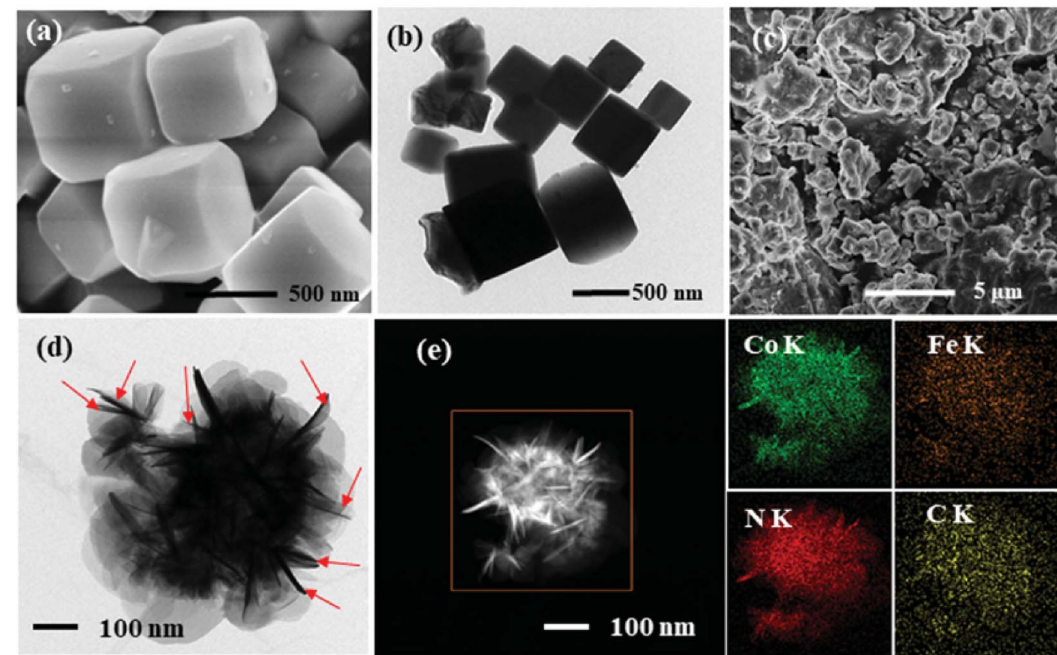
Fig. 7 Morphological and elemental characterization of LDHs. a SEM of PBA, b TEM of PBA, c SEM of PBA/CoFe-LDH, d TEM of PBA/CoFe- LDH and e EDS of PBA/CoFe-LDH, adapted with permission from ref. 145 , Copyright, 2022,